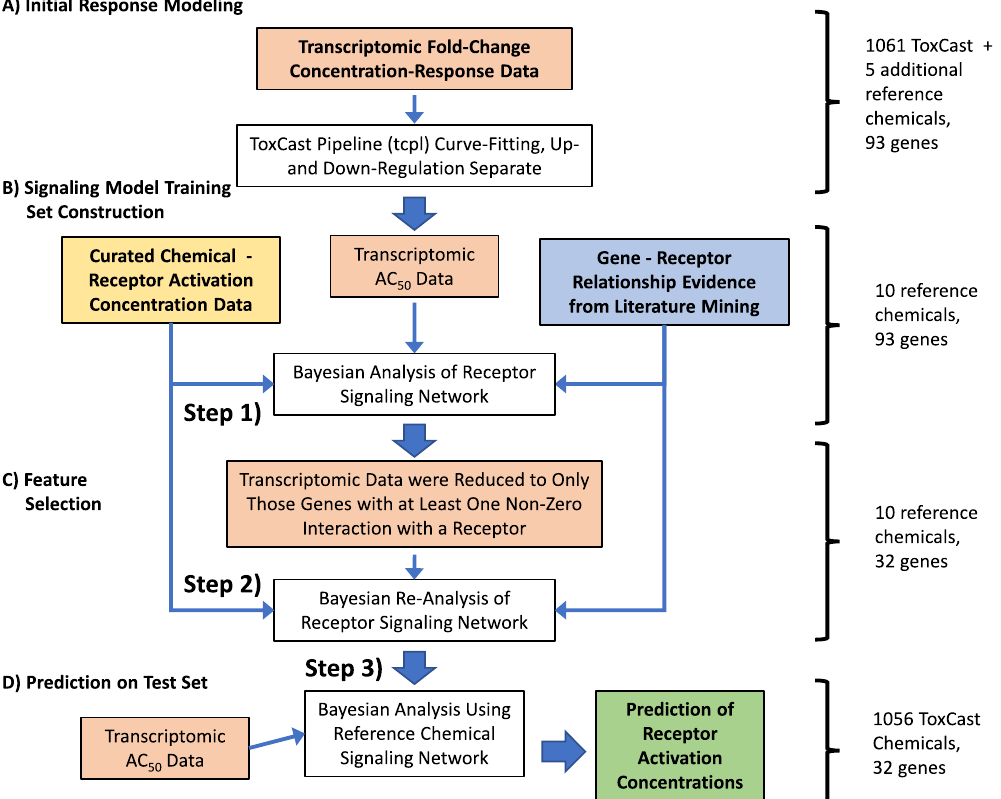
Fig. 4 Overview of analysis. Initial curve fi tting was performed to identify concentrations causing fi fty percent activity (AC50), if any. The signaling network model was then trained in three steps (see Table 1). Transcriptomic, gene-receptor literature data, and chemical-receptor potency data are shaded